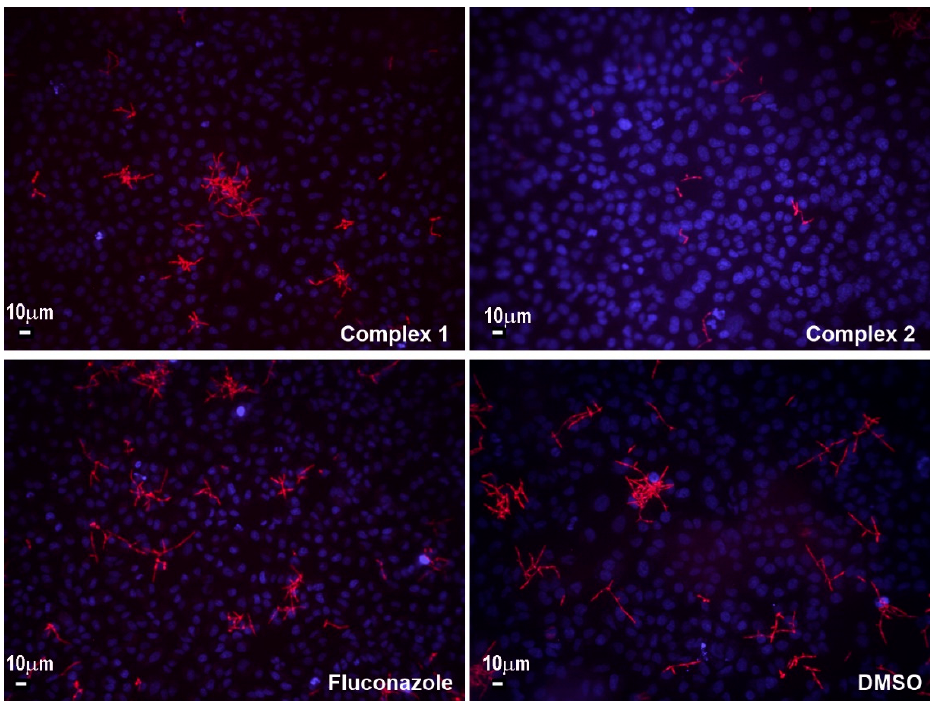
Figure 6. The adhesion of fluorescent C. albicans SC5314-RFP on A549 cells in the presence of complexes 1 and 2 , and fluconazole (Olympus BX51, Applied Imaging Corp., San Jose, CA, United States, under 20× magnification; scale bar representing 10 µm). DAPI (2-(4-amidinophenyl)-6-indolecarbamidine dihydrochloride) stained nuclei appear in blue, while fluorescent red is from labeled C. albicans cells.